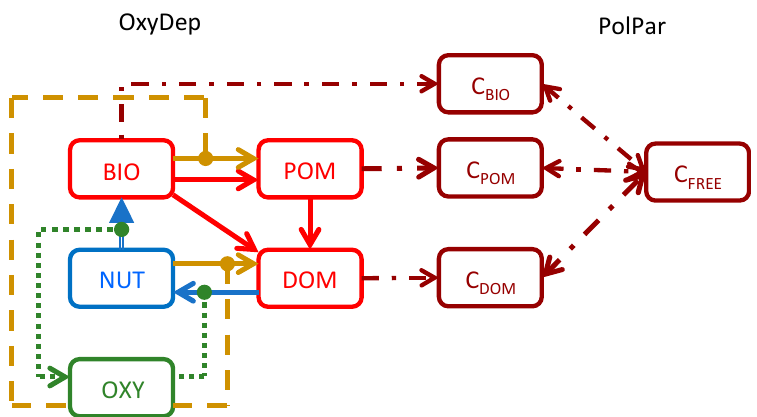
Figure 2. Schematic diagram of biogeochemical processes in the biogeochemical module (Oxygen Depletion Model (OxyDep)) and its coupling to the pollutant-partitioning model (PolPar). It is assumed that the total pollutant can be partitioned between pollutant ( C BIO ) in biota (BIO), pollutant ( C POM ) in particulate organic matter (POM), pollutant ( C DOM ) in dissolved organic matter (DOM), and remaining free dissolved fraction ( C FREE ).